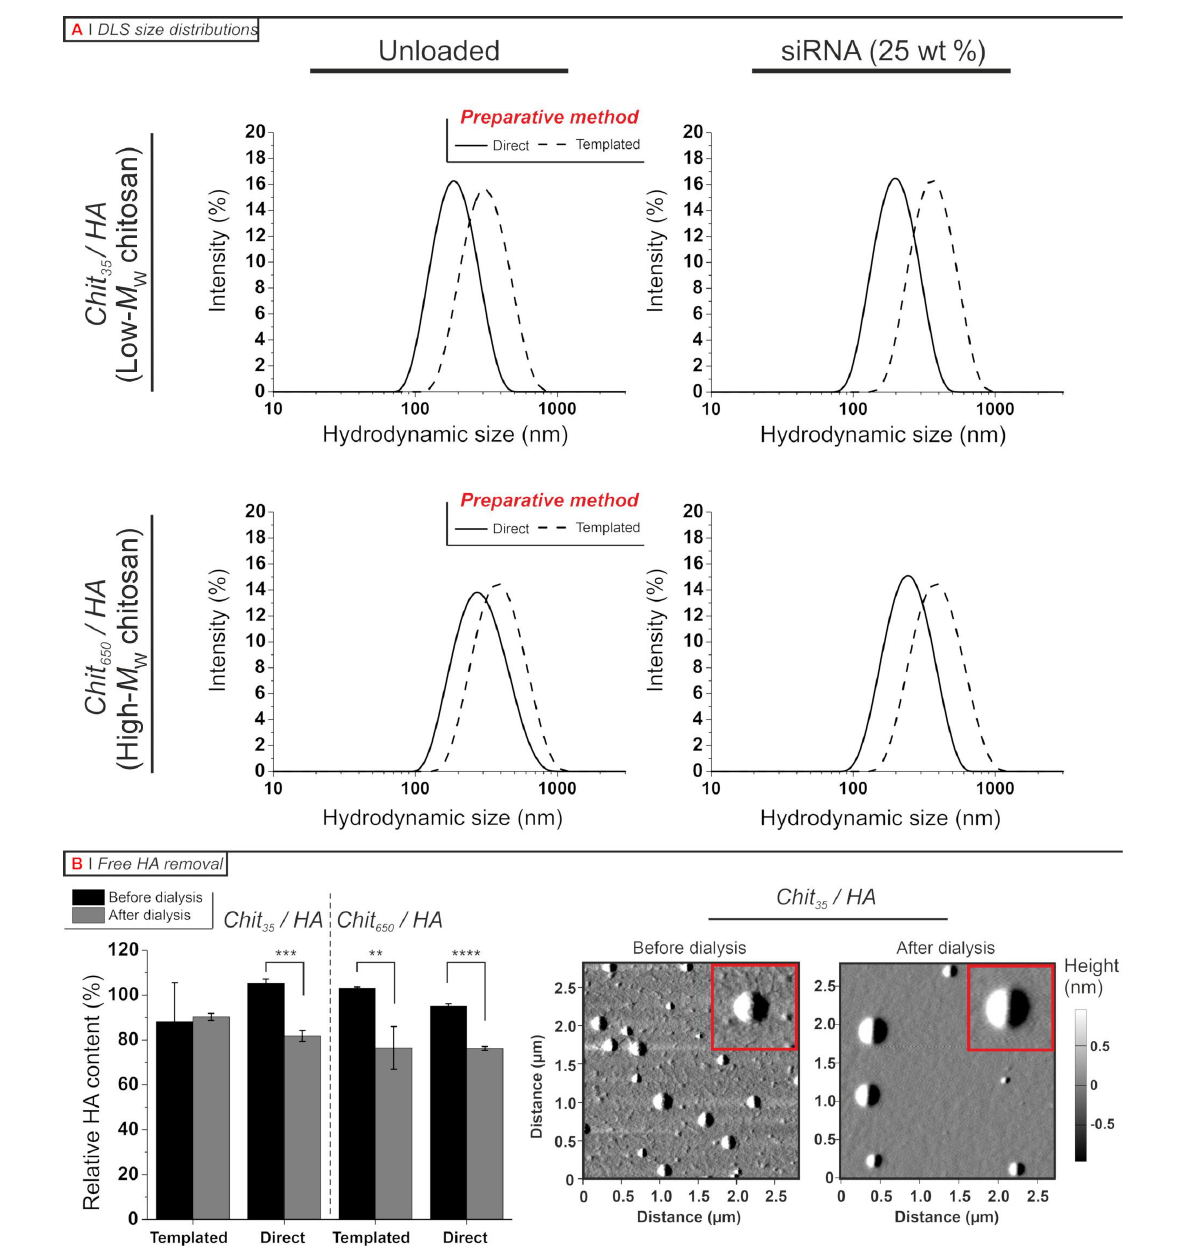
Figure 1: A) Size distribution of chitosan/HA nanoparticles (1 mg/mL, deionized water) prepared from 35 (top) and 650 (bottom) kDa chitosan using a templated (dashed lines) or direct (solid lines) complexation in the absence (left) or presence (right) of siRNA (25 wt % in relation to chitosan). In this and later figures Chit 35 and Chit 650 are, respectively, referred to as low- M W and high- M W chitosan to avoid the use of subscripts for a better read- ability. B) Quantification of free HA after nanoparticle preparation. Left: The HA content of the different nanoparticle formulations (1 mg/mL, deionized water) was measured by capillary electrophoresis before and after dialysis (MWCO = 1,000 kDa). Results are expressed as the relative amount of complexed HA (incorporated in the nanoparticle) relative to the total amount of HA in the nanoparticle feed ( n = 3). Right : AFM amplitude images of (low- M W chitosan) nanoparticles after dialysis showing the complete removal of unbound HA (absence of “debris” material on the mica